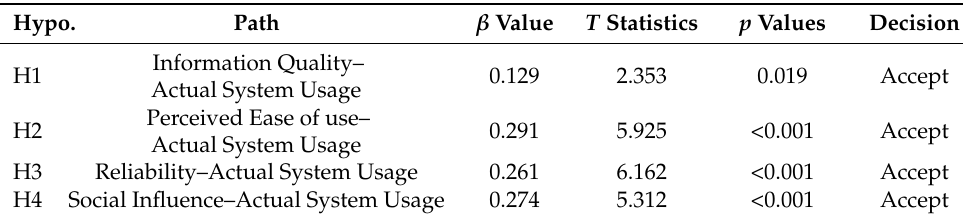
Table 6. T-Test with a Significance Level.